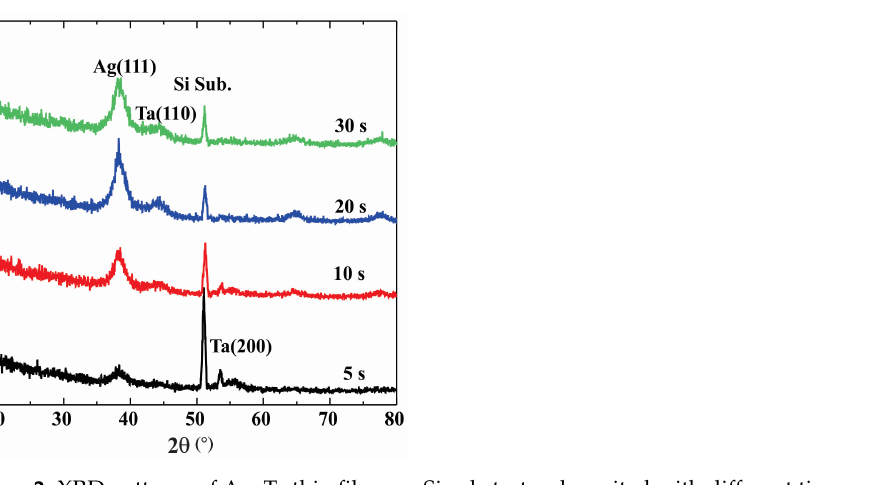
Figure 2. XRD patterns of Ag–Ta thin films on Si substrates deposited with different times.